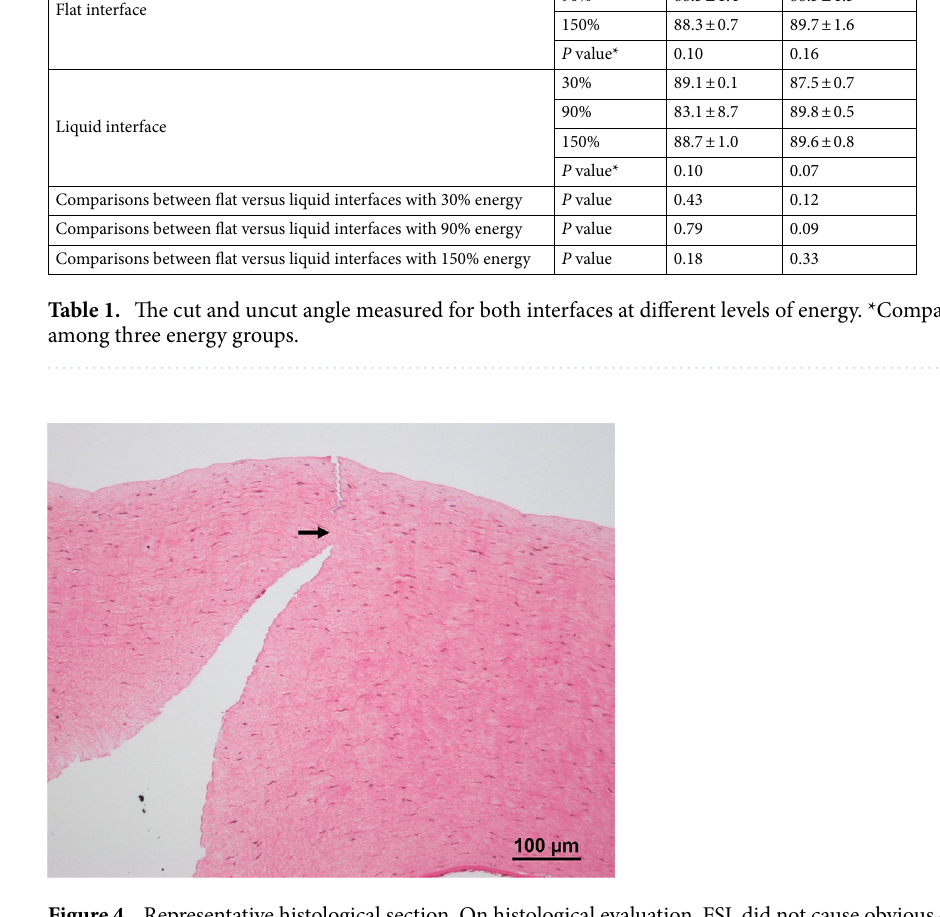
Figure 4. Representative histological section. On histological evaluation, FSL did not cause obvious coagulative necrosis, inflammation, or thermal burn along the laser path irrespective of the energy used. Arrow indicates the uncut